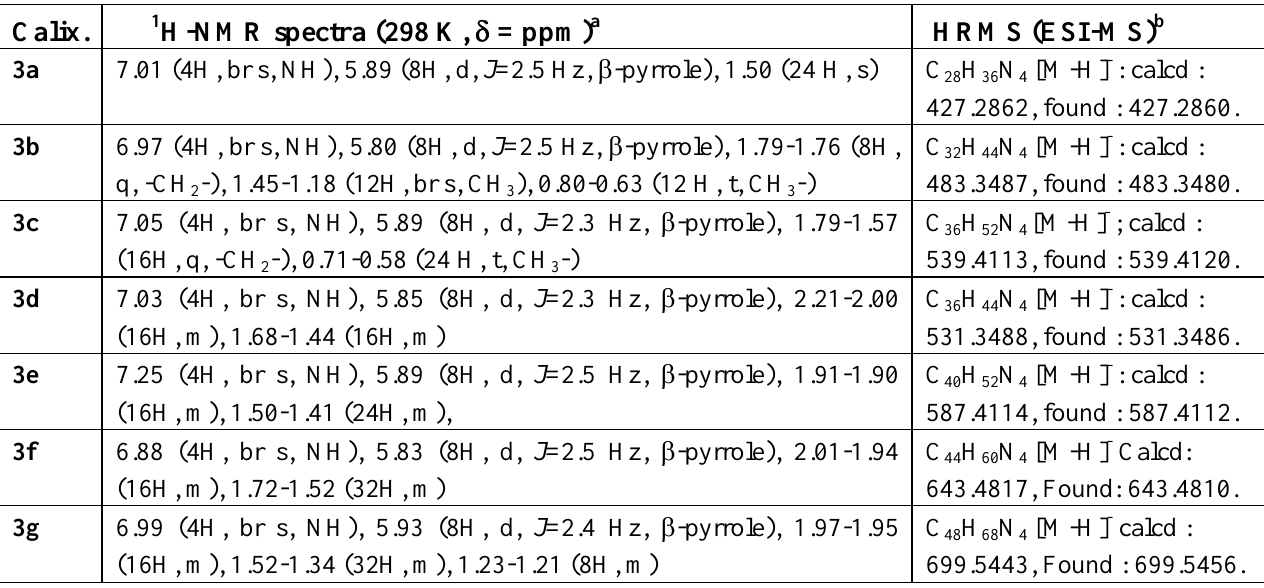
Table 3: 1 H-NMR and mass spectra of meso-octaalkyl and cycloalkyl calix[4]pyrroles 3a-3g . Calix.